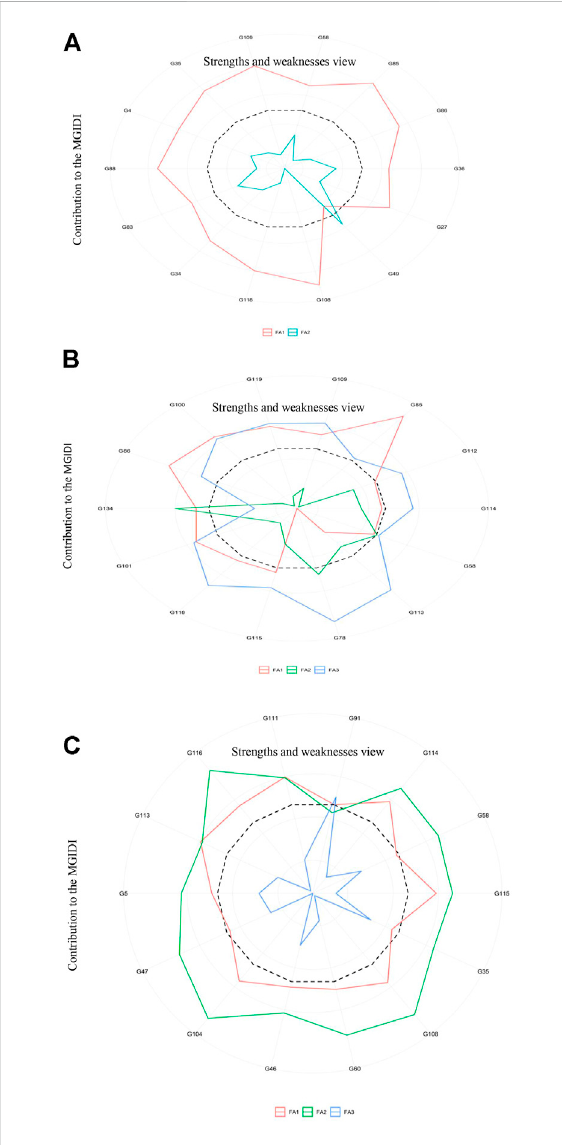
FIGURE 7 Strengths and weaknesses of the stable genotypes identi fi ed